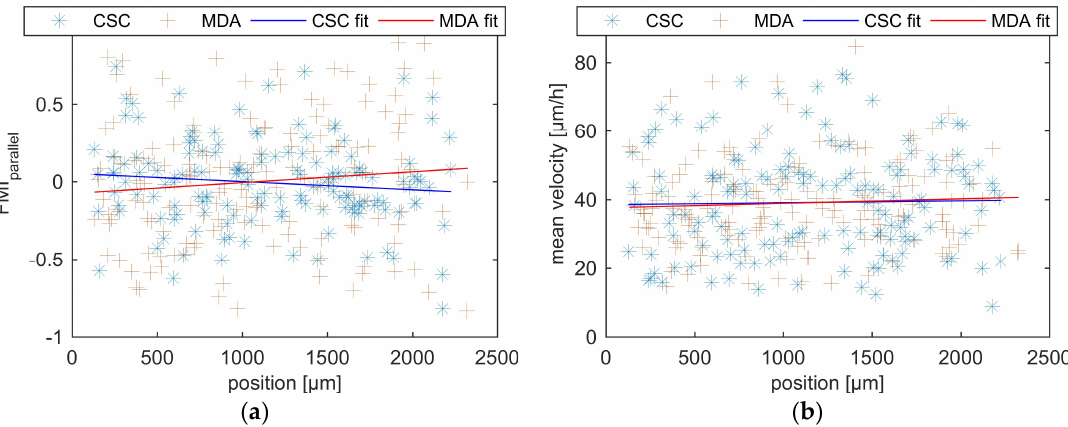
Figure A5. The FMI parallel and average migration velocity without gradient (at environmental oxygen level), as a function of the average x-position relative to the chamber wall: ( a ) The FMI parallel of all tracked cells and ( b ) the average measured migration velocity of all tracked cells.